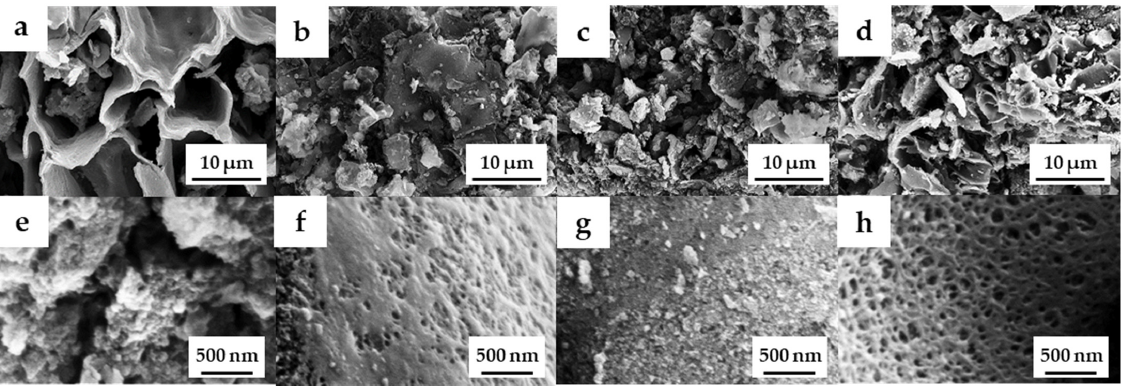
Figure 2. FE-SEM images of ( a , e ) OPL − HTC − 800, ( b , f ) OPL − KOH − 800 − 1:0.25, ( c , g ) OPL − KOH − 800 − 1:1, and ( d , h ) OPL − KOH − 800 − 1:4.